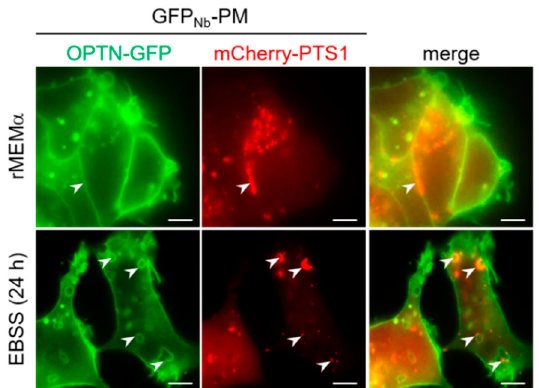
Figure 13. Co-expression of OPTN-GFP and a plasma-membrane-targeted anti-GFP nanobody recruits peroxisomes to the plasma membrane. DD-DAO Flp-In T-REx 293 cells were transiently co- transfected with plasmids encoding a plasma membrane targeting motif-tagged anti-EGFP nanobody (GFP Nb -PM), OPTN-GFP, and mCherry-PTS1, then cultured in rMEM α . The next day, the medium was replaced with fresh medium or EBSS and, 24 h later, the cells were imaged using fluorescence microscopy. Representative images are shown. The white arrowheads indicate positions where peroxisomes are associated with the plasma membrane. Scale bar, 10 µm.